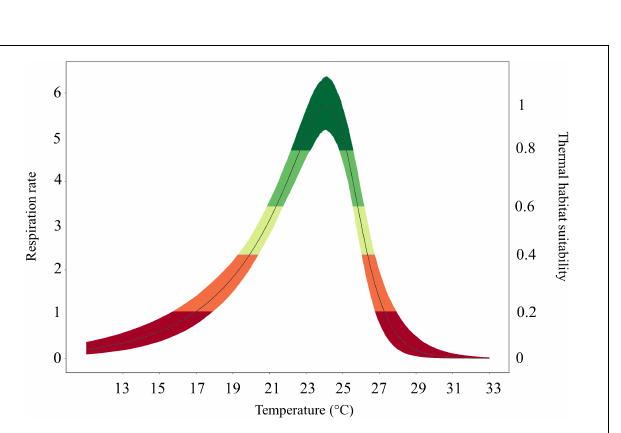
FIGURE 3 | Thermal habitat suitability scale within the thermal performance curve of the species ranging from low (0) to high (1) species occurrence probability. Different colors (representing the species thermal habitat suitability) would correspond to: optimum temperature range (dark green colored), lower and upper pejus ranges (light green and yellow colored), pessimum (orange colored), and lethal ranges (red colored) according to Sokolova et al.